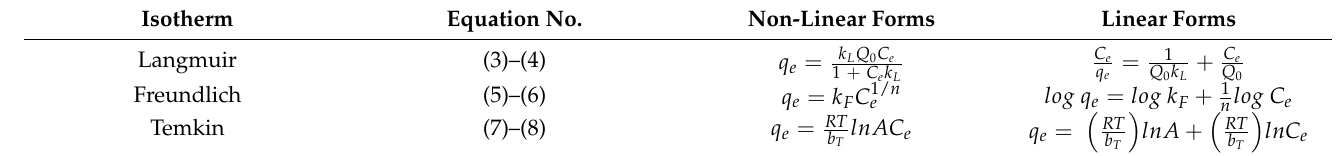
Table 1. Isotherm models used for description of BY2—C/SiO 2 and BB3—C/SiO 2 systems. Isotherm Equation No. Non-Linear Forms Linear Forms Langmuir Freundlich Temkin where: q e —the amount of basic dye adsorbed per unit mass of C/SiO 2 at equilibrium (mg/g), C e —the equilibrium concentration of solution (mg/L), Q 0 —the monolayer adsorption capacity (mg/g), k L —the Langmuir constant (related to the free energy of adsorption)